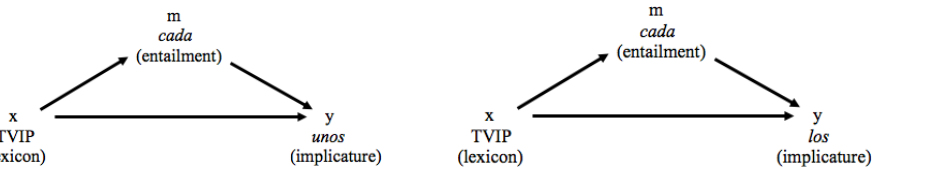
See, along these lines, Pratt et al. (2019) for the visual working memory differences between consecutive and simultaneous action. Figure 1. Mediation